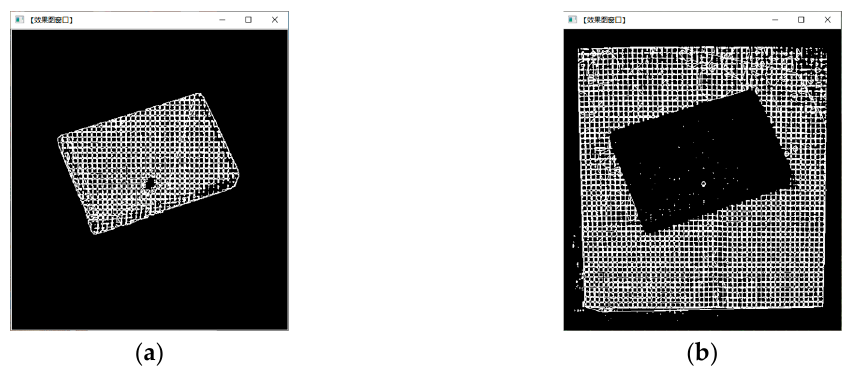
Figure 13. Division of obstacle areas. ( a ) The area of the obstacle; ( b ) the area of the ground.